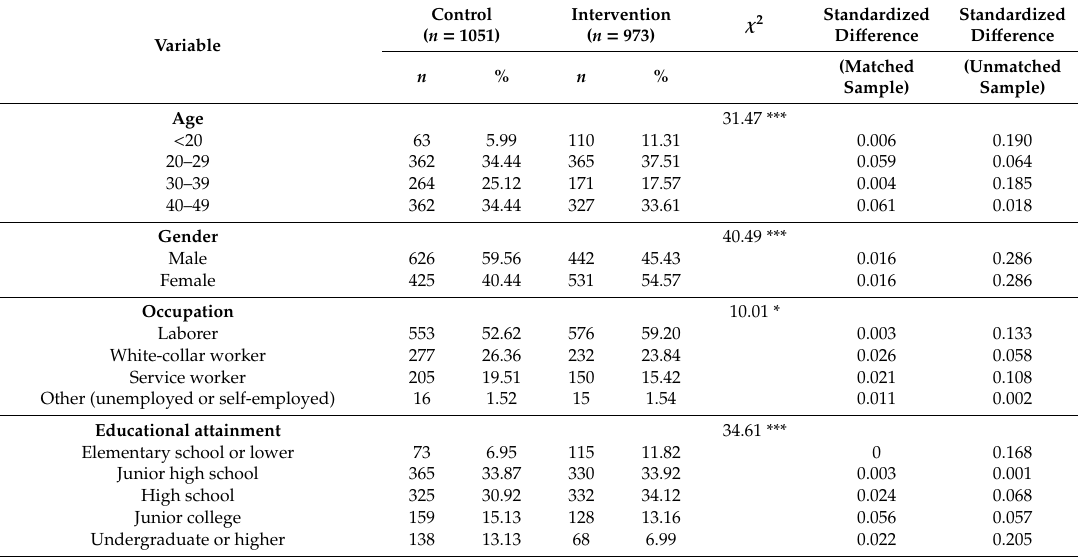
Table A6. Comparison of demographic characteristics among participants between intervention and control groups in Chongqing ( n =